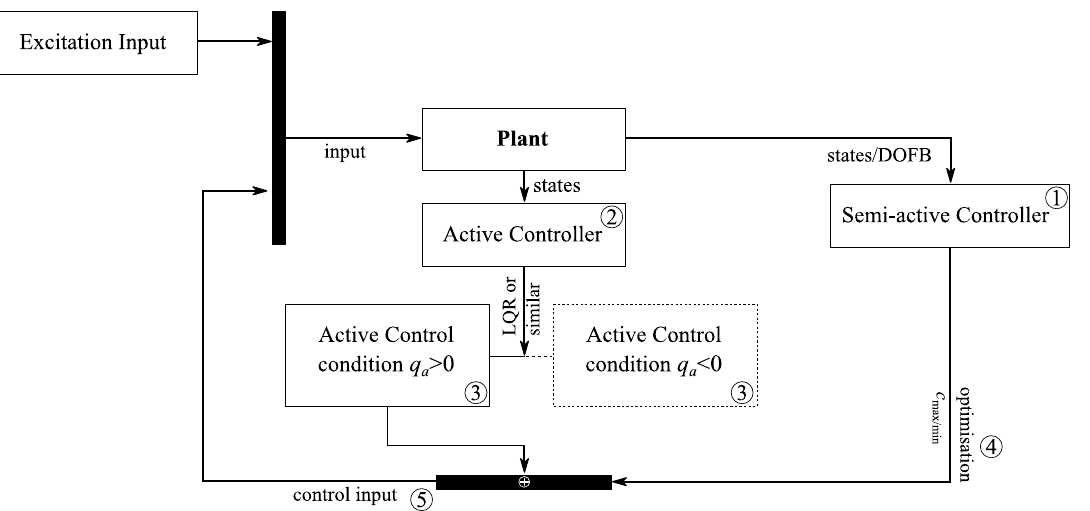
Figure 3. A schematic representation of the procedure followed for modeling the semi ‐ active hybrid mass damper. mass damper.